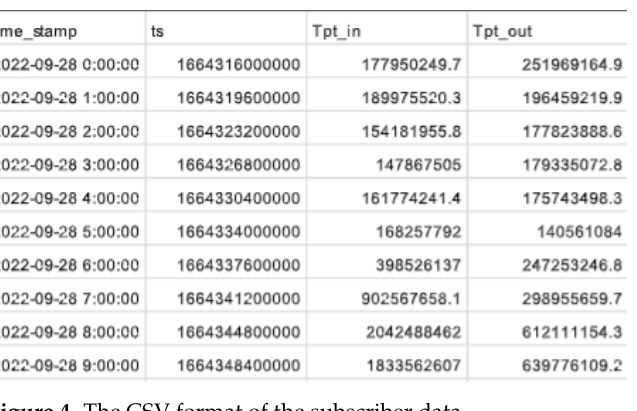
Figure 4. The CSV format of the subscriber data.